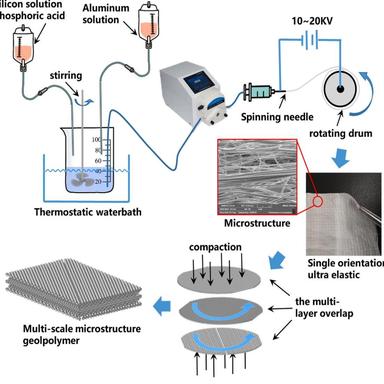
Schematic diagram of the production process.